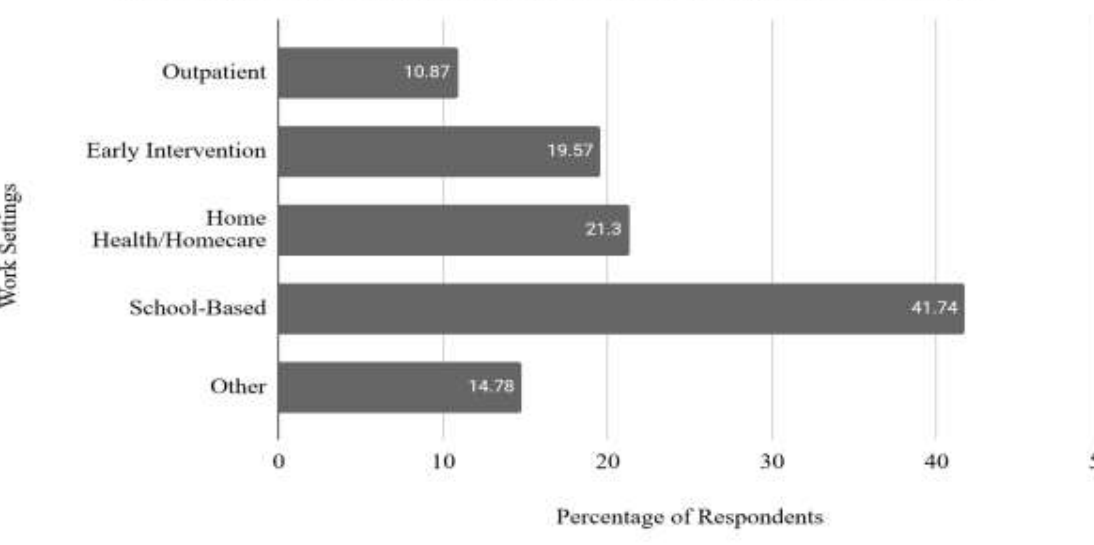
Percentages of OTPs Work Setting Where They Have Used